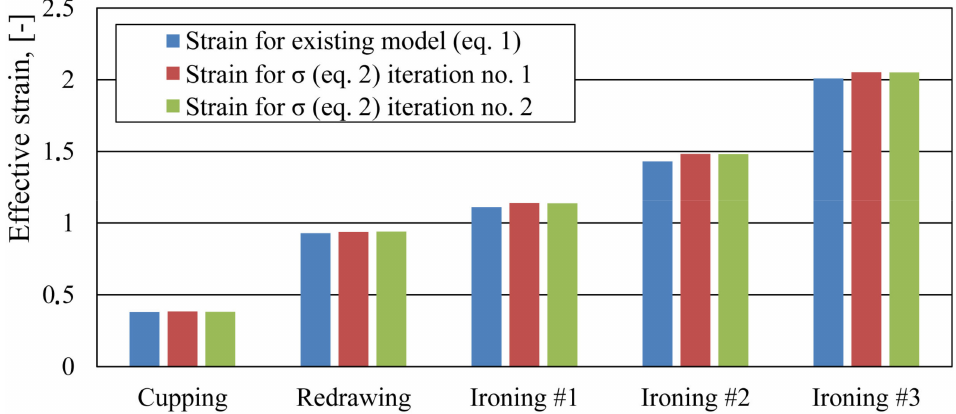
Figure 11. Effective strain values from the numerical simulation for material models (1) and (2) from the first and second iteration of the fitting algorithm.